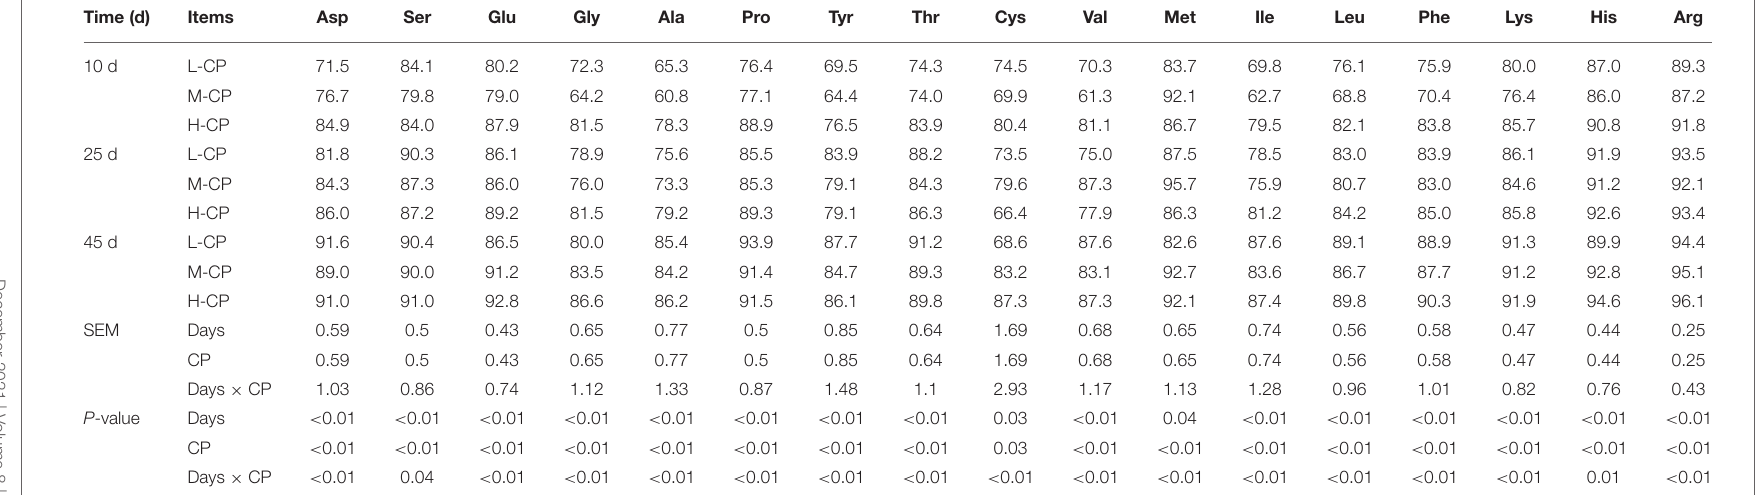
TABLE 5 | Effects of dietary protein levels on the AA apparent digestibility in feces of piglets (%). Time